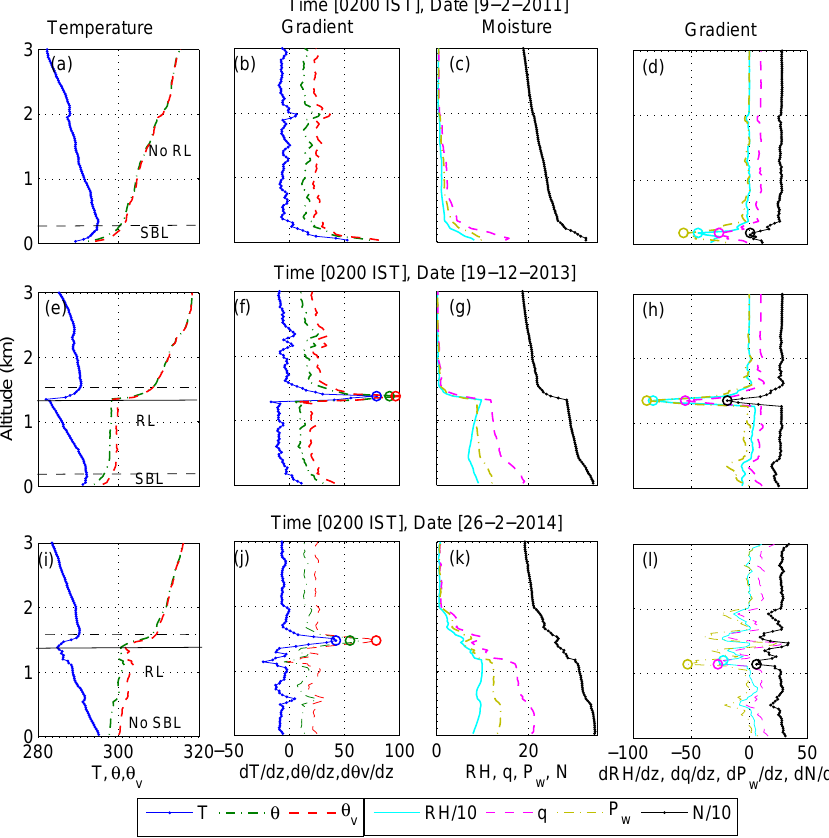
Figure 3. Same as Fig. 2 but for nighttime profiles observed at 02:00IST, indicating (a) the stable boundary layer (SBL) but not the residual layer (RL) observed on 9 February 2011, (b) both the SBL and the RL observed on 19 December 2013, and (c) the RL but not the SBL observed on 26 February 2014. The horizontal dashed lines denote the surface-based inversion in the temperature profile and open circles denote maximum gradients in temperature variables or minimum gradients in the moisture variables. Horizontal dash-dotted lines indicate capping inversion